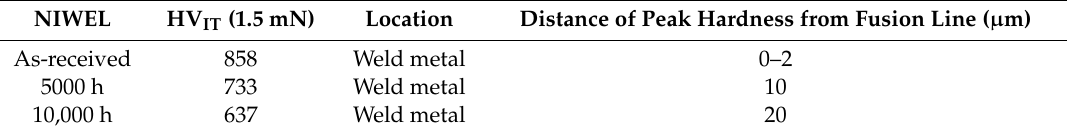
Table 4. Summary of the main nanoindentation hardness results and their locations at the LAS / Alloy 52 weld metal for NIWEL AR, NIWEL 5000 h and NIWEL 10,000 h.